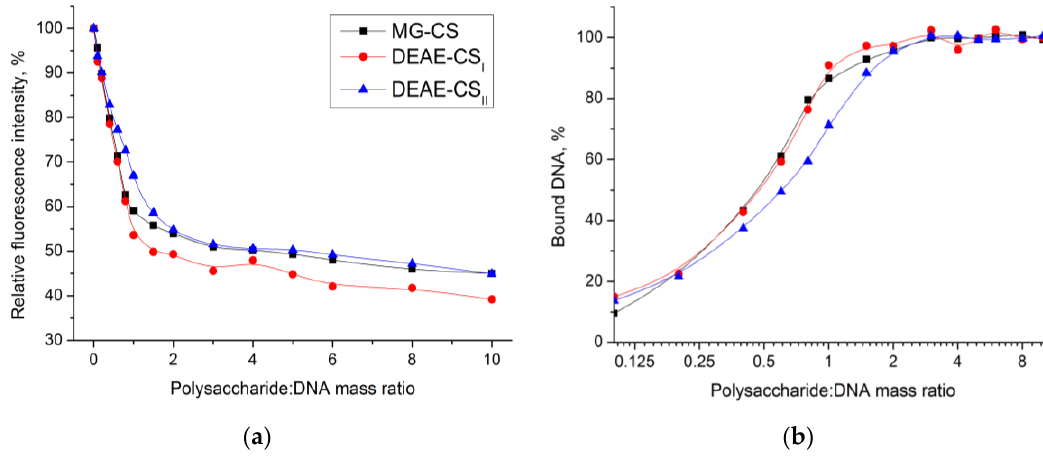
Figure 5. Ethidium bromide displacement curves represented as ( a ) Relative fluorescence intensity quenching; ( b ) Bound DNA fraction as a function of polysaccharide: DNA mass ratio; n = 3.